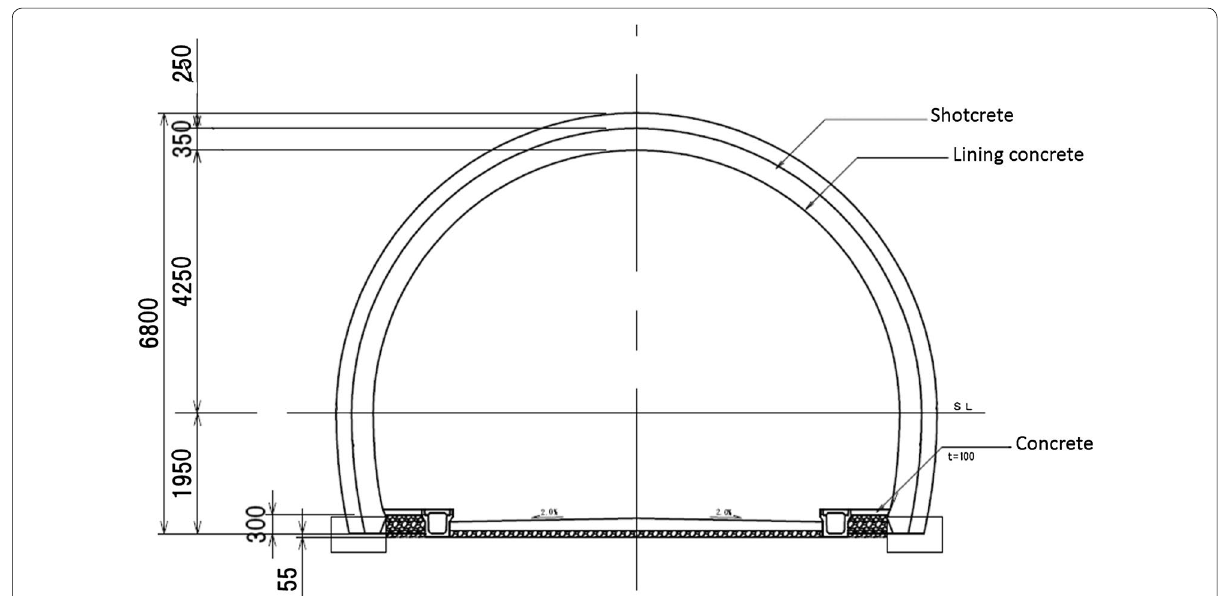
Fig. 12 Schematic of the experimental tunnel used in field environment testing for our proposed method (dimensions specified in mm)